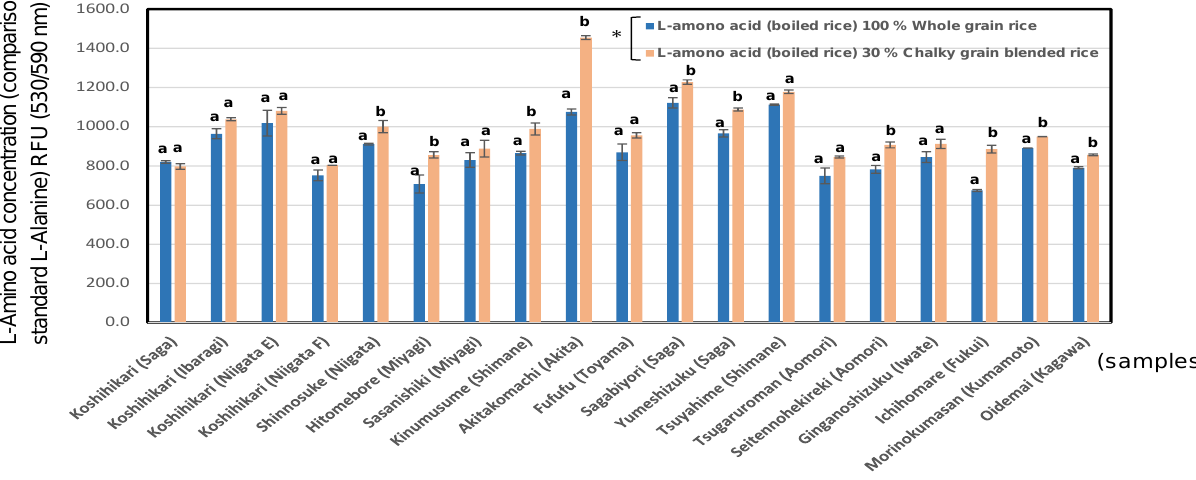
Figure 8. L -amino acid of 100% whole rice boiled grains and 30% chalky blended grains in 19 kinds of Japonica rice in 2020. Different letters (a, b) mean that whole and 30% chalky grains in each same rice samples are significantly different. * Correlation is significant at 5% by the Tukey’s multiple comparison